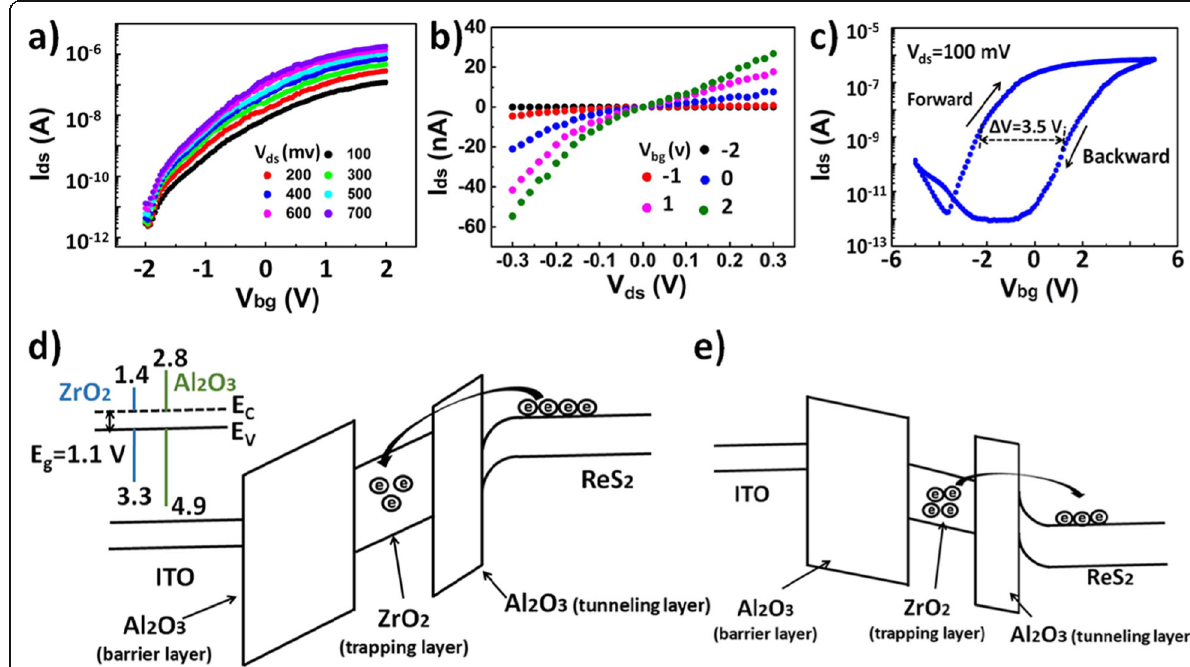
Fig. 2 Electrical properties of the ReS 2 synaptic devices. a Transfer characteristic ( I ds – V bg ) of the ReS 2 synaptic devices at a fixed V ds changing from 100 to 700 mV with the step of 100 mV. b Output characteristic ( I ds – V ds ) of the ReS 2 synaptic devices at a fixed V bg changing from − 2 to 2 V with the step of 1 V. c Hysteresis loop at V bg of ± 5 V sweep ranges. V ds was kept at 100 mV. d Energy band diagram of the ReS 2 synaptic devices with positive back gate voltage. Inset: energy levels of Al 2 O 3 and ZrO 2 . e Energy band diagram of the ReS 2 synaptic devices with negative back gate